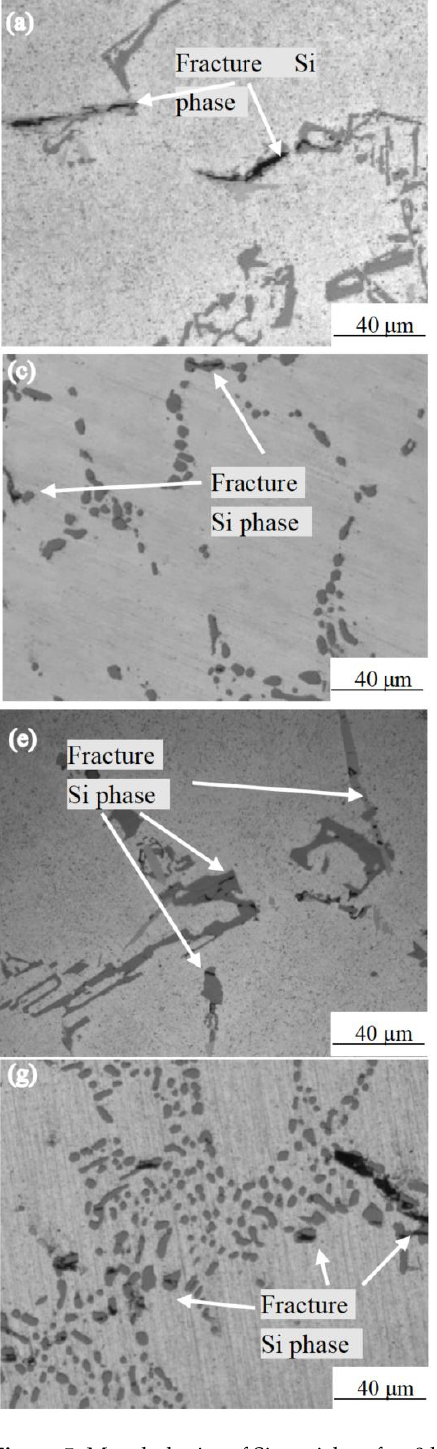
Figure 5. Morphologies of Si particles after 0 h and 10 h solution treatment: ( a ) as-cast microstructure, 20 °C; ( b ) as-cast Si phase morphology,20 °C; ( c ) 10 h solution treatment microstructure, 20 °C; ( d ) 10 h solution treatment Si phase morphology, 20 °C; ( e ) as-cast microstructure, −60 °C; ( f ) as-cast Si phase morphology, −60 °C; ( g ) 10 h solution treatment microstructure, −60 °C; ( h ) 10 h solution treatment Si phase morphology, −60 °C.